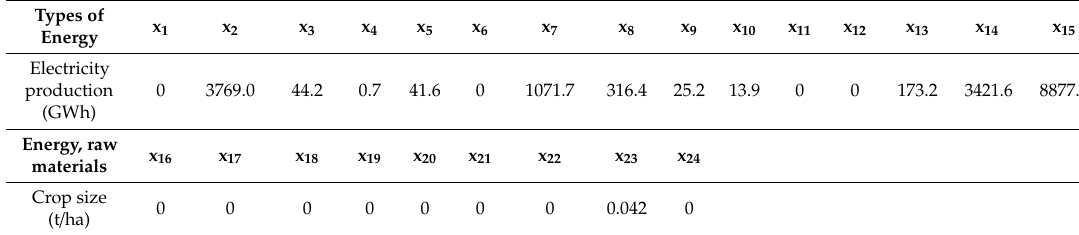
Table 11. Results of scenario I run for 2021.